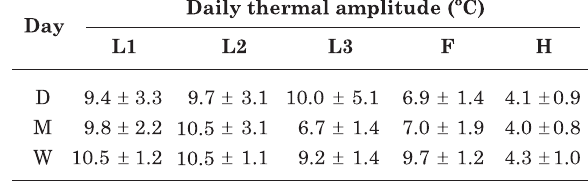
Table 5. Mean and standard deviation values of average daily thermal amplitudes in L, F and